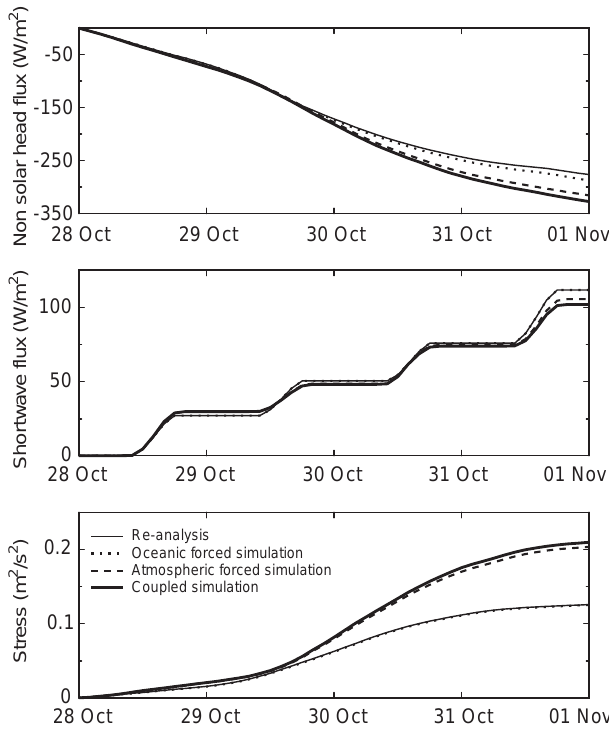
Fig. 7. From top to bottom: evolution of non-solar heat flux, shortwave flux and stress averaged on the simulation domain. Fluxes from ARPEGE re-analyses ( solid ), forced oceanic simulation ( dotted ) forced atmospheric simulation ( dashed ) and coupled simulation ( dot- dashed